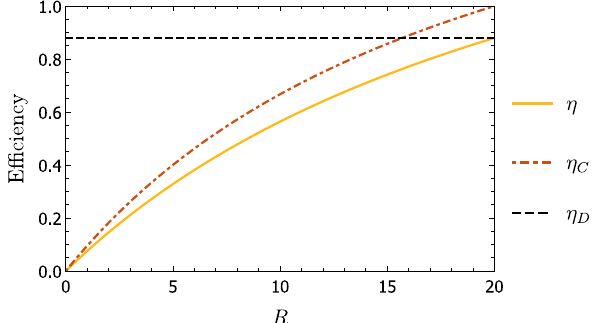
Fig. 2 The efficiency of a heat engine of accelerating black holes is plotted as a function of radius R . Here, we assume the center of the circular cycle in P − V plane is ( V 0 , P 0 ) = ( 100 , 20 ) with the cosmic string tension μ − = 0 . 2, then the radius for a valid heat engine cycle